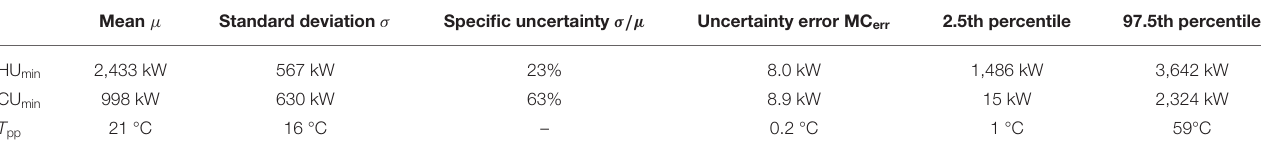
TABLE 2 | Uncertainty analysis results.